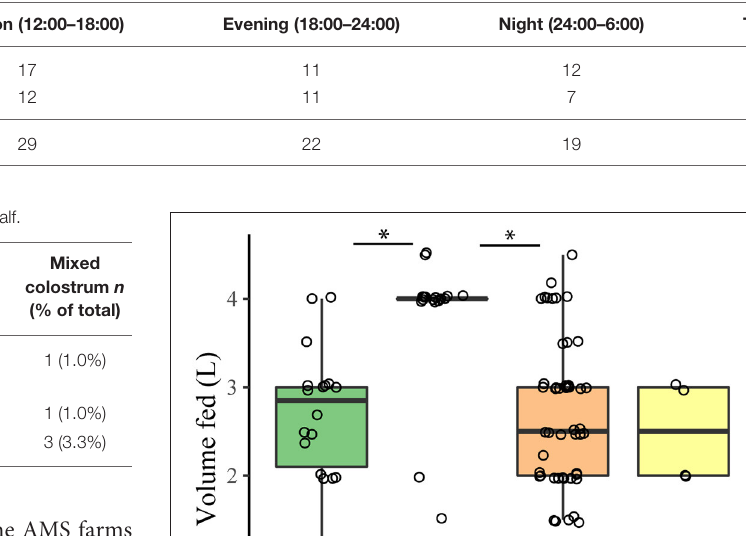
TABLE 1 | General calving statistics of the most recently born calf by time of calving and sex.